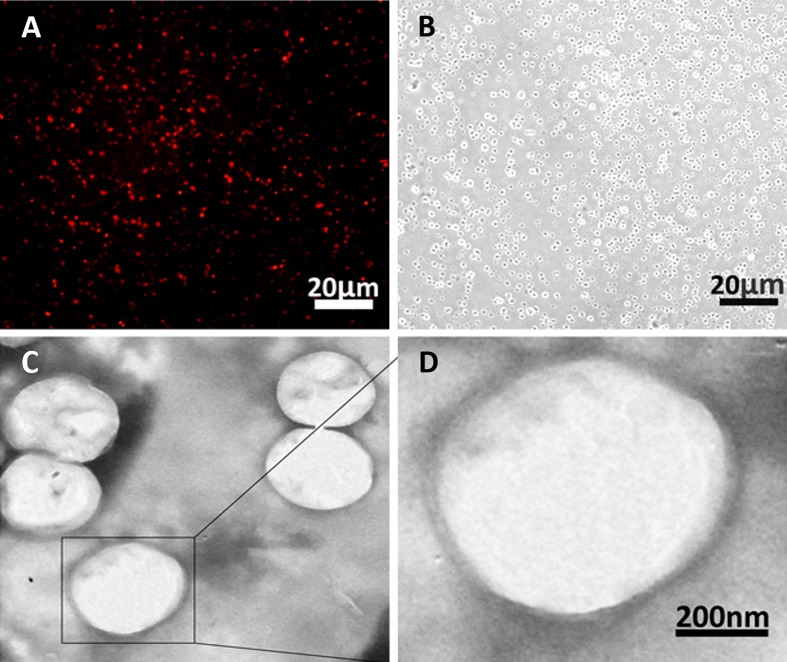
Morphology of nanobubbles produced by optimal centrifugation. (A) Fluorescence field of nanobubbles at ×400 magnifications. (B) Corresponding bright field of nanobubbles was observed. (C and D) The micrograph of nanobubbles obtained by TEM.